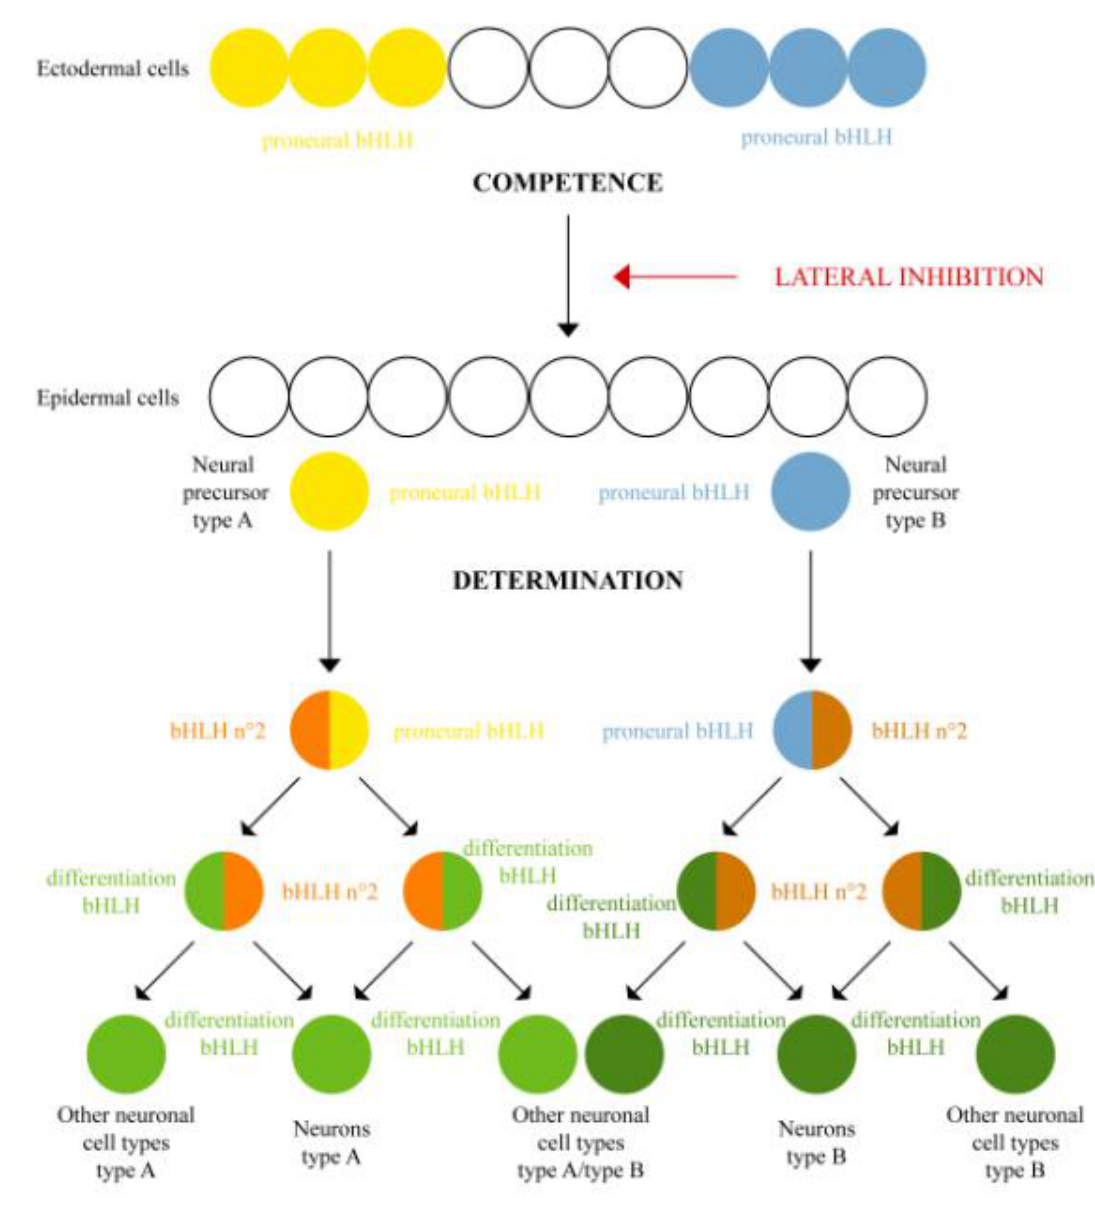
FIGURE 2. A general model for the function of bHLH during neural development. Some ectodermal cells express one specific bHLH (proneural bHLH) and acquire the competence to become neural precursors. Among those cells, a few isolated ones become irreversibly fated as neural precursors (determination) while most of the other revert to an epidermal fate by virtue of lateral inhibition. Neural precursors usually delaminate from the ectoderm and follow specific and reproducible lineages. Depending on the proneural bHLH expressed, neural precursors are committed to produce particular types of neurons (here mentioned as type A and B). Several bHLH are expressed during these lineages, in an overlapping way, from the proneural toward the differentiation bHLH. In the figure, only one intermediate (bHLH n°2) is shown but there may be more. The intermediate and differentiation bHLH found in the A and B lineages are shown as different genes but they may be